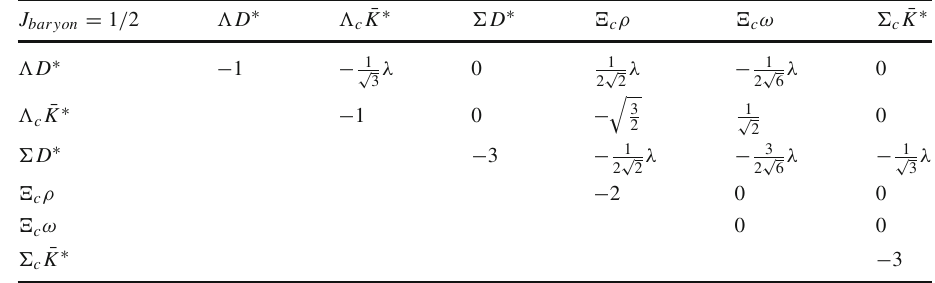
Table 8 D ij coefficients for the V B states coupling to